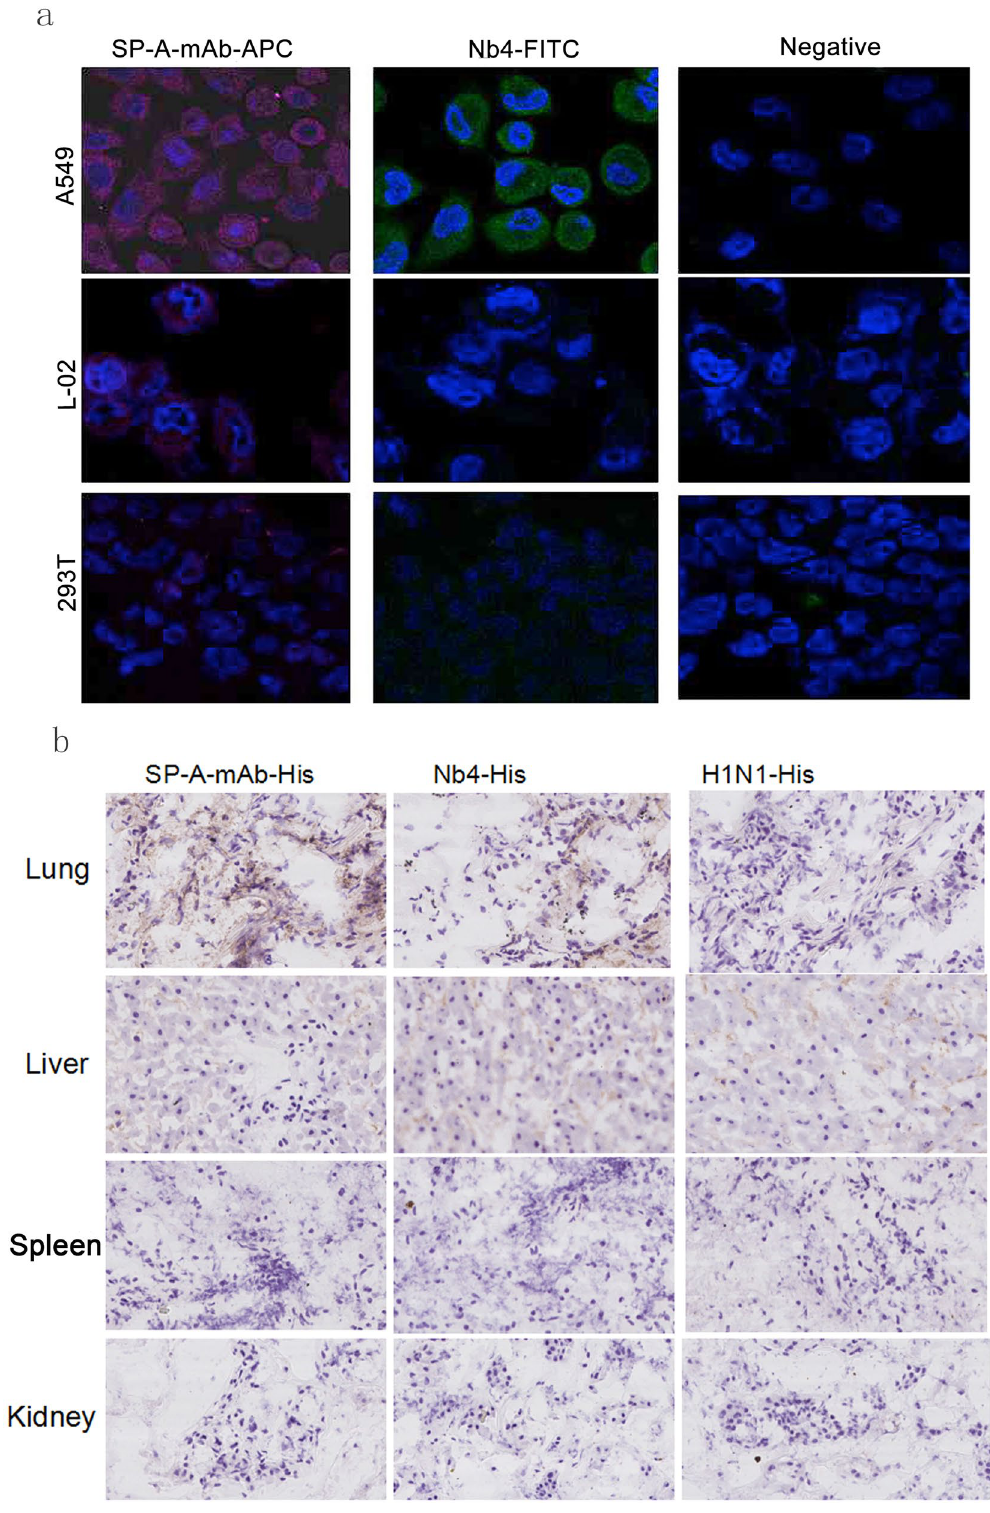
Figure 5. Immunofluorescent staining and immunehistochemical staining with Nb4. ( a ) Human epithelial A549 cells were positively stained with Nb4. Human lung epithelial A549 cells, human liver L-02 cells, and human kidney 293 T cells were fixed and stained with SP-A-mAb, Nb4-FITC, and off-target Nb (negative). ( b ) Human lung tissues were positively stained with Nb4. Human lung, liver, spleen, and kidney tissue specimens were stained with SP-A-mAb, Nb4-His, and H1N1-His (off-target